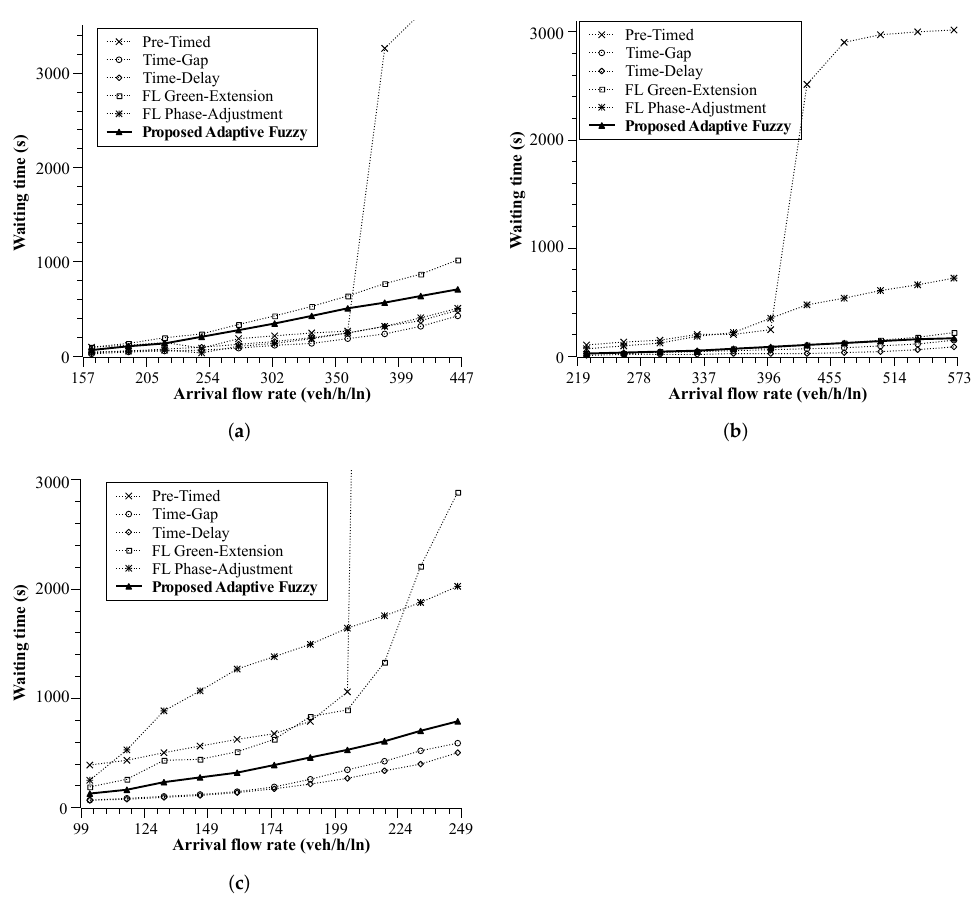
Figure 8. Waiting time as a function of the averaged system’s arrival flow rate: ( a ) stream A, ( b ) stream B, and ( c ) stream